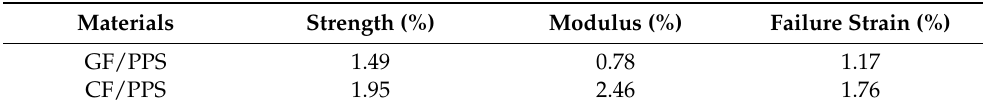
Figure 8. Illustration of out-of-plane compression failure mechanism of woven thermoplastic composites. Table 4. Mean absolute percentage errors ( MAPE ) of predicted mechanical properties of thermoplas- tic